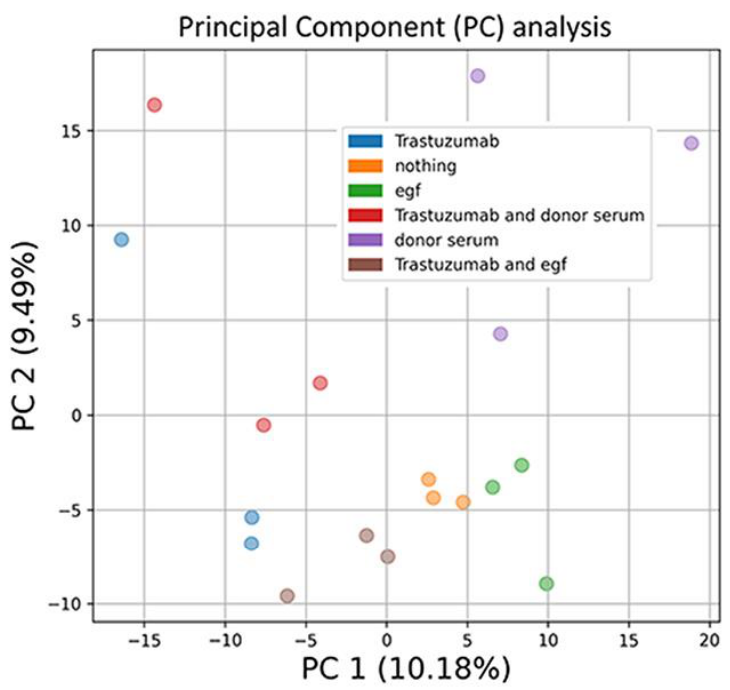
Figure 7. Principal component (PC) analysis of log-transformed gene expression profiles. The color key indicates functional groups of samples. The proportion of standard deviation for the respective PC is shown in brackets.